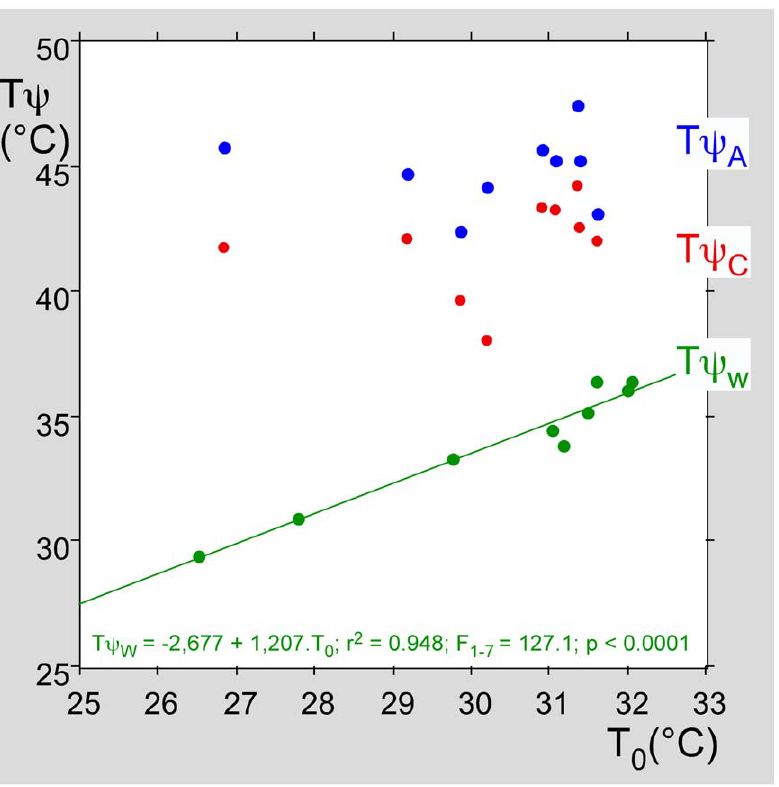
Figure 6. Relationships between the initial temperatures of the skin and the thresholds. Relationships between the initial temperatures of the skin and the thresholds: thermal threshold (in green), threshold of responses elicited by C- (in red) and A d -fibers (in blue). There was no correlation between the initial temperature of the skin and the threshold, no matter which type of fibers were triggering pain. On the other hand, the thermal threshold was very dependent on the initial temperature of the skin. A clear linear relationship was seen between the initial temperature of the skin and the threshold of heat detection (T y W = 2 2,677 + 1,207.T 0 ; r 2 =0.948; F 1–7 =127.1; p , 0.0001), which means that these subjects detected variations of temperature in the 2–3 u C